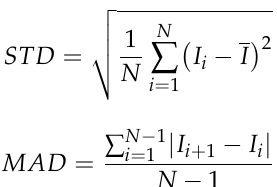
Figure 16. The number of valid samples per day.